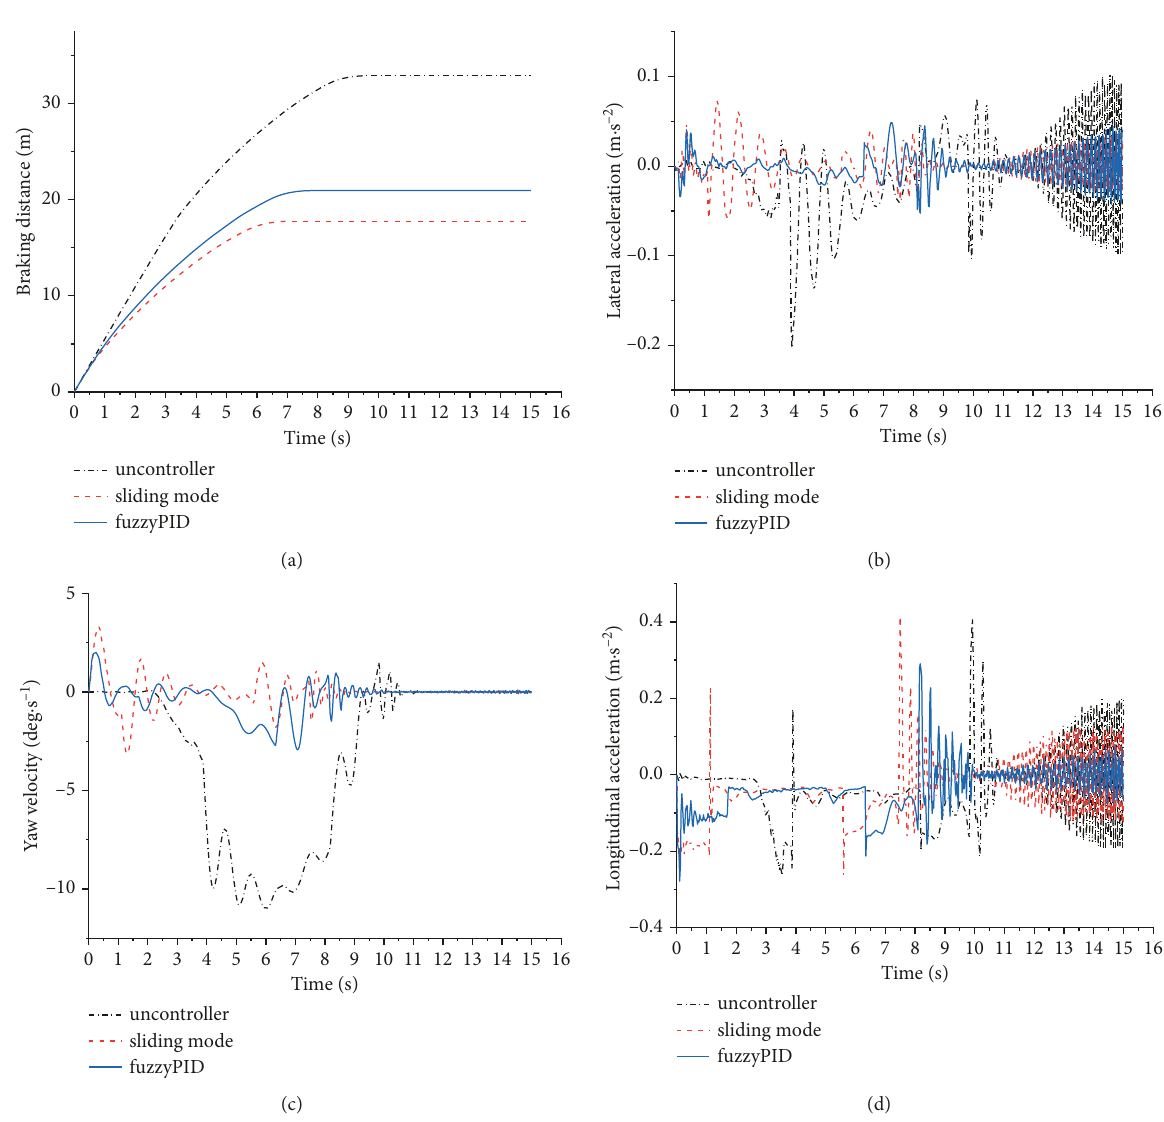
Figure 17: Simulation comparison diagram of different controls in curve driving with u � 0.7. (a) Braking distance. (b) Lateral acceleration. (c) Yaw velocity. (d) Longitudinal acceleration.